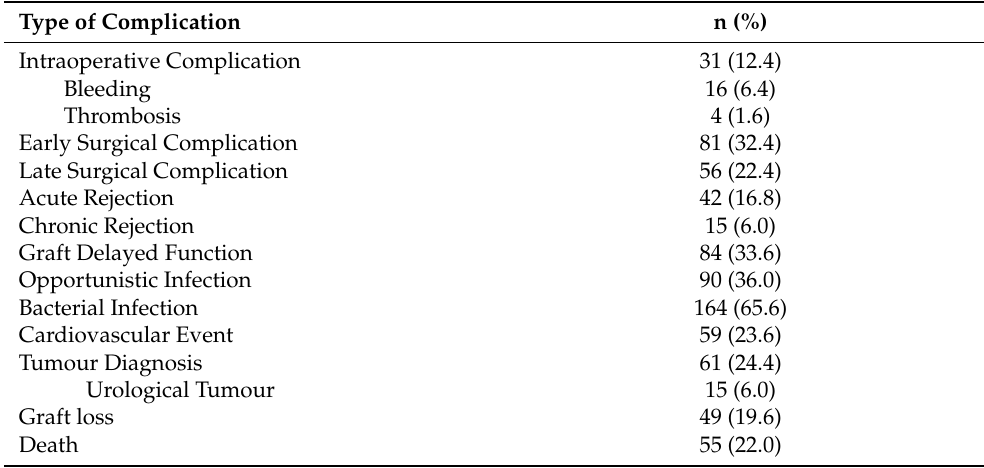
Table 2. Descriptive analysis of the frequency of the main complications recorded in the study population during